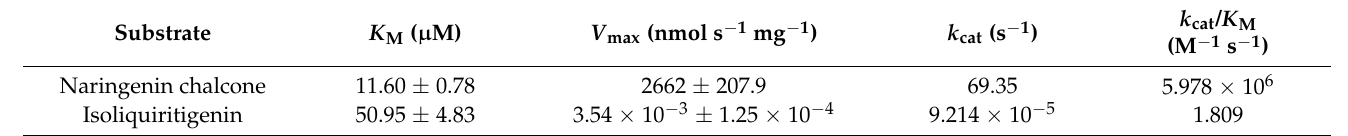
Table 2. Kinetic parameters of recombinant OsCHI3. 1.